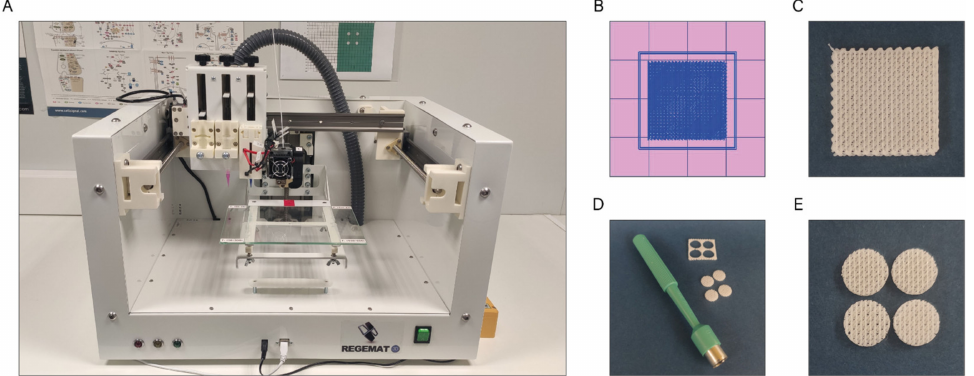
Figure 11. ( A ) REGEMAT 3D Bio V1 ® bioprinter, ( B ) scaffold design with REGEMAT 3D Designer v1.4.4, ( C ) 3D-printed scaffolds of 1.50 × 20 × 20 mm (height × width × length), ( D ) disk